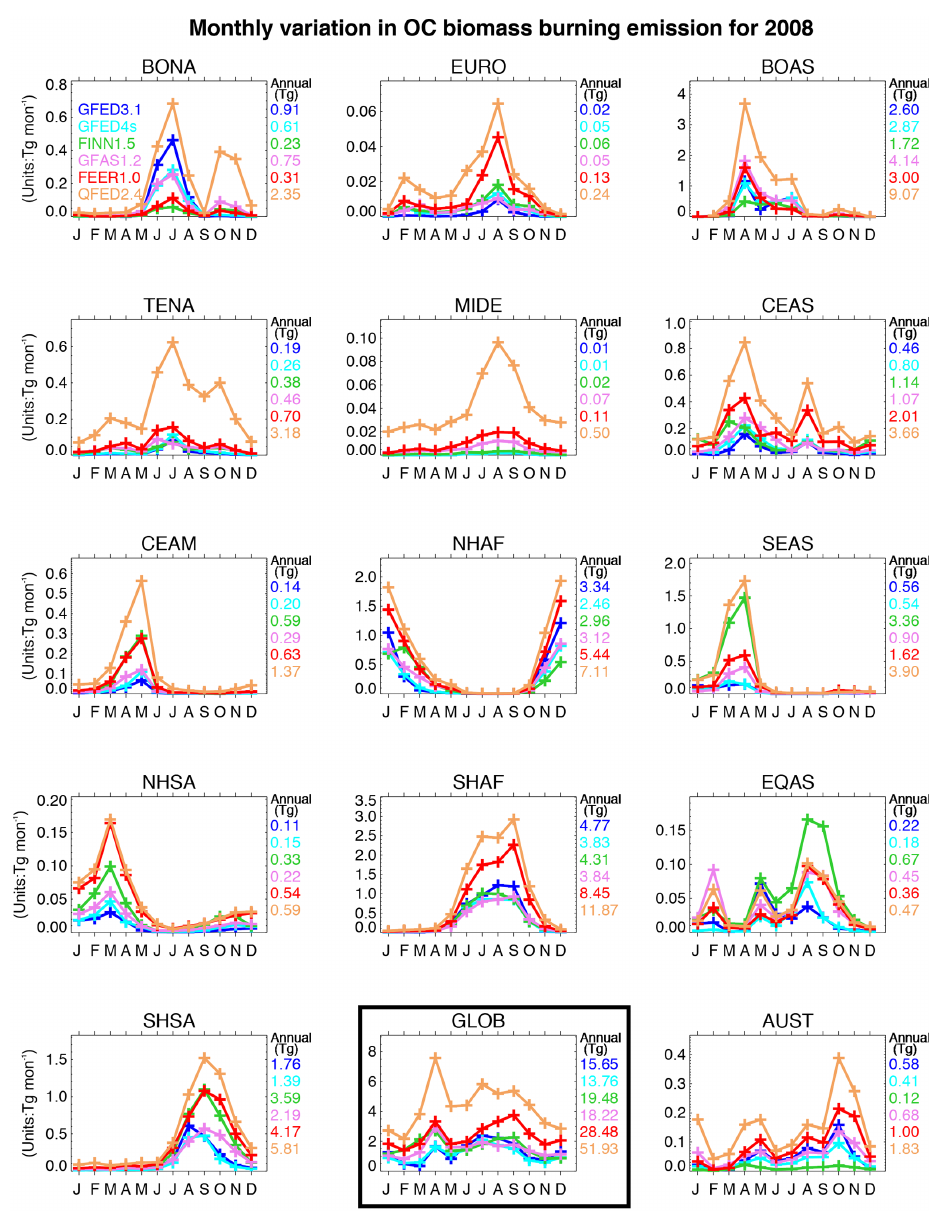
Figure 4. Monthly variation in organic carbon (OC) biomass burning emissions for 2008 in six biomass burning emission datasets in 14 regions and the globally (i.e., GLOB, highlighted with a black box). The annual total emission is listed on the right side of each panel.